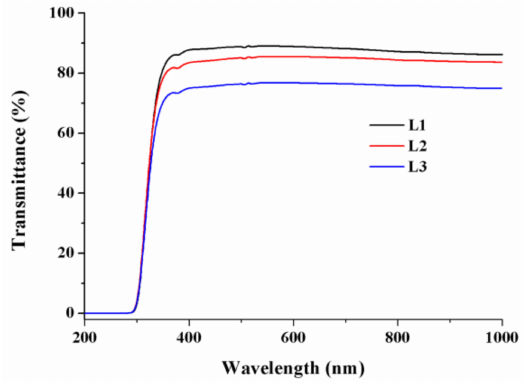
Figure 6. Transmittance spectra of L1–L3 thin films.